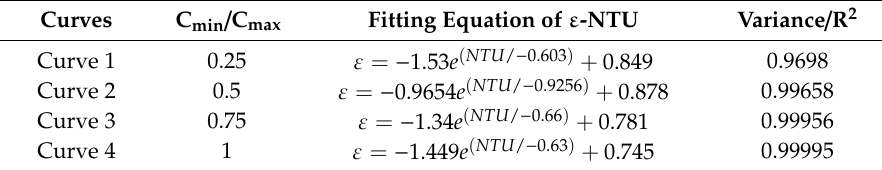
Figure 14. ε -NTU plots and fitting curves under different specific heat capacity ratios. Table 3. Fitting equations of ε -NTU.